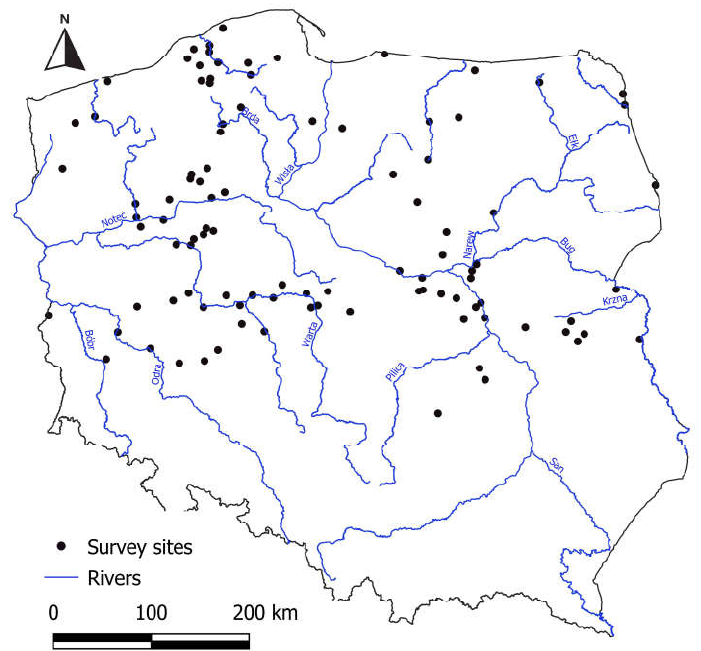
Figure 1. Distribution of the survey sites throughout the lowland part of Poland.